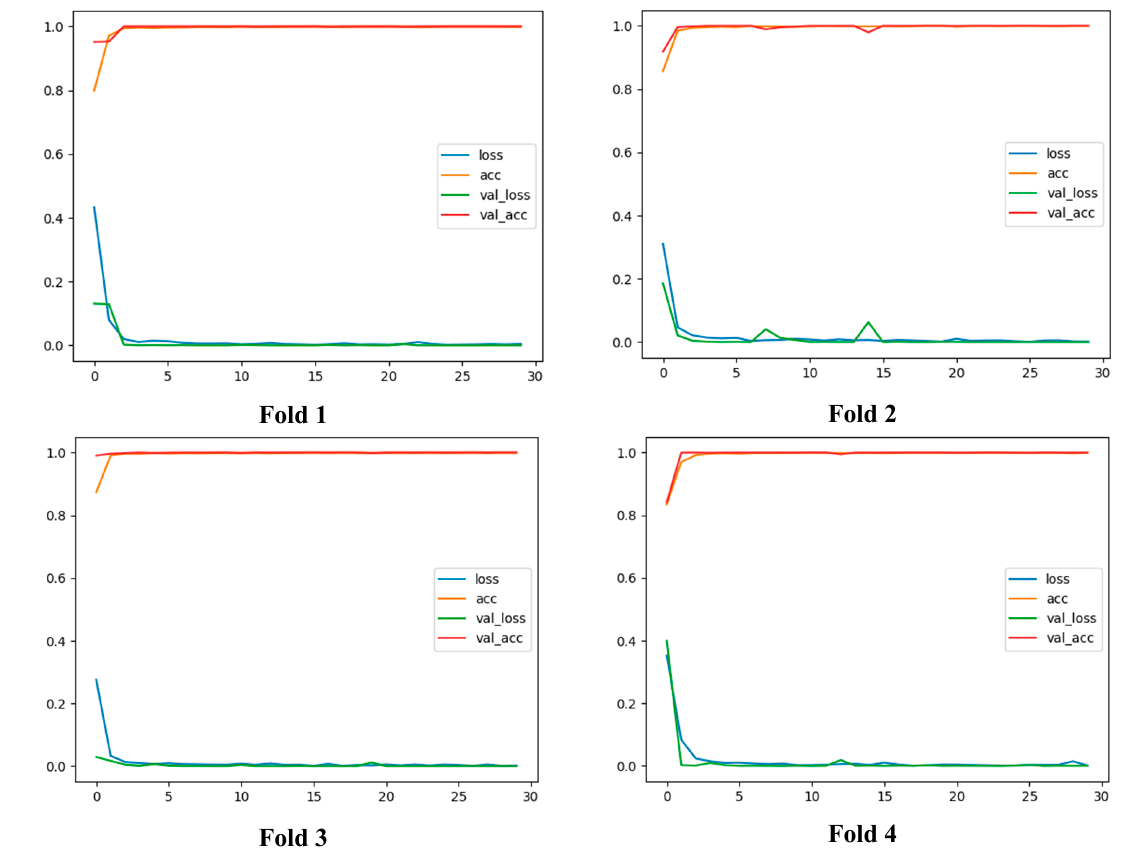
Figure 8. Generated images from the trained BGAN model.